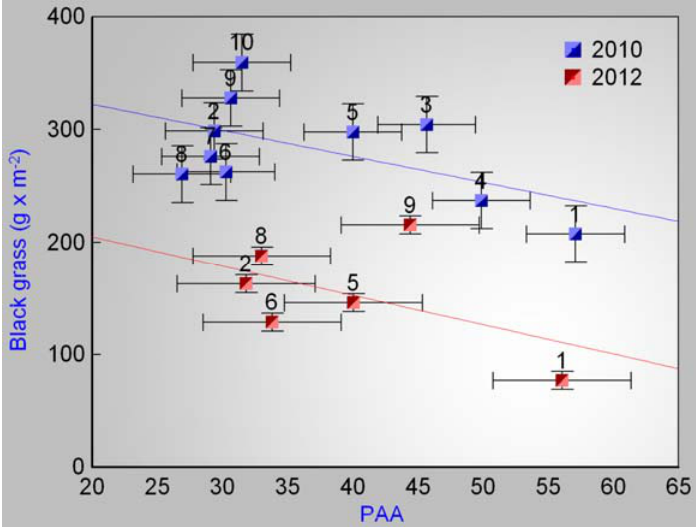
Figure 4. Relationship between potential allelopathic activity (PAA) of winter wheat cultivars (incl. the triticale cultivar Dinaro (1)) and total aboveground biomass of black-grass at time of heading of wheat in two different years. For cultivar identification codes see the Materials section. Bars indicate two standard errors (SE).